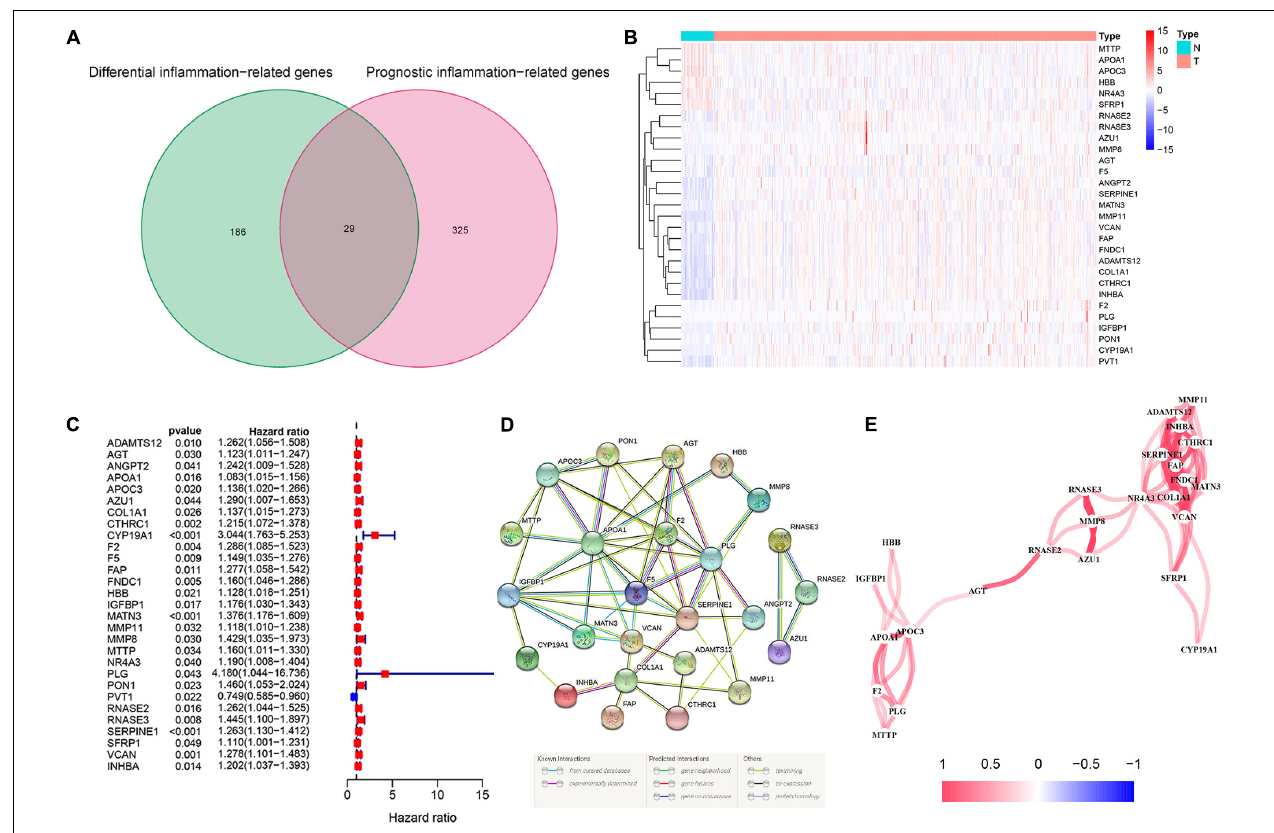
FIGURE 3 | Identification of the candidate inflammation-related genes in the Cancer Genome Atlas (TCGA) cohort. (A) Venn diagram to identify differentially expressed and prognostic inflammation-related genes. (B) The heatmap of differentially expressed and prognostic inflammation-related genes. (C) Forest plots of the association between 29 differentially expressed and prognostic inflammation-related genes and overall survival (OS). (D) The protein–protein interaction (PPI) network of differentially expressed and prognostic inflammation-related genes (interaction score = 0.4). (E) The correlation network of candidate genes.